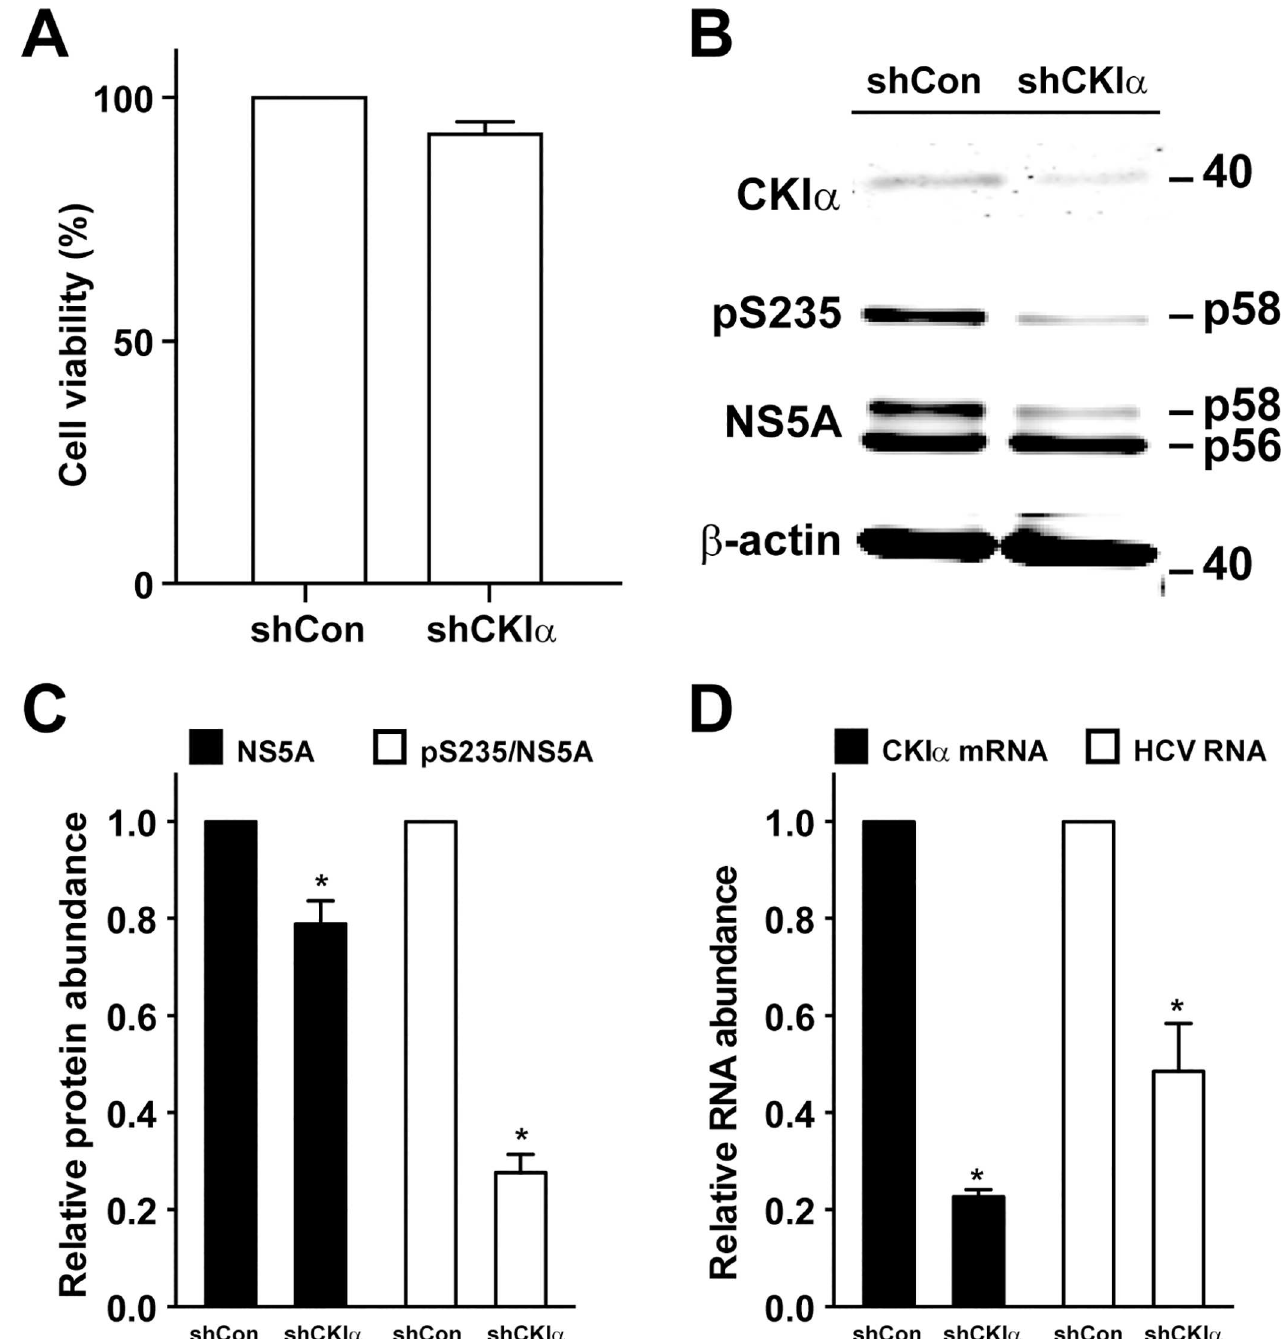
Fig 6. CKI α knockdown reduced NS5A S235 phosphorylation and HCV RNA levels in the infected Huh7.5.1 cells. (A) Viability of the Huh7.5.1cells with or without CKI α knockdown assessed with the MTT assay. (B) Representative and summary (C) of the immunoblotting for CKI α , NS5A and NS5A phosphorylation at S235 (pS235)in the HCV-infected Huh7.5.1cells with or without CKI α knockdown. One day after the cells were infected with HCV (J6/JFH1), the cells were subjectedto shRNA-basedCKI α knockdown for 6 days prior to the immunoblotting analysis. Values are Mean ± SEM (n = 3). Asterisk indicatessignificancei.e. p < 0.05,t-test againstthe values in the non-targeted control cells (shCon). Protein abundance was quantifiedwith the Li-Cor scanner, adjustedfor the loadings(i.e. against β -actin) and normalized with the values in the control cells. (D) CKI α mRNA and HCV RNA levels measured with quantitative RT-PCR in the HCV-infected Huh7.5.1cells with or without CKI α knockdown. The experiments were done as those in b except that RNA was collected for the analysis. The GAPDH mRNA levels were analyzedas loadingcontrols. RelativeRNA abundance was normalizedwith the values of the control